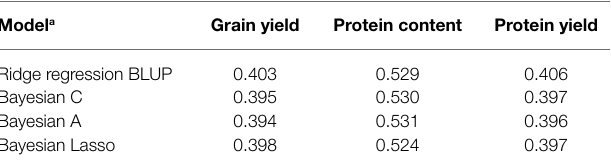
Results averaged across three connected RIL populations and all possible validation